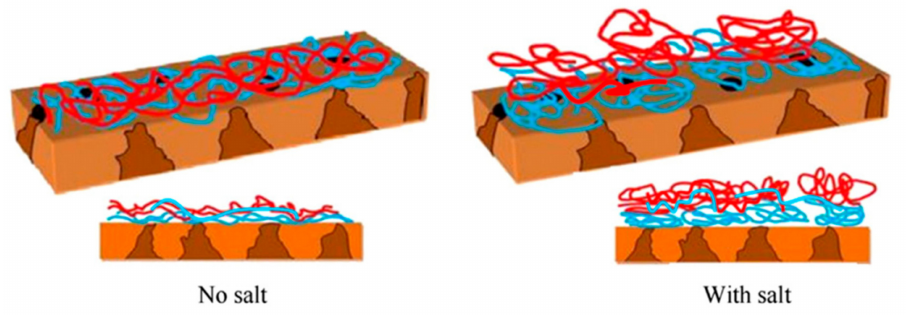
Figure 10. Effect of salt addition towards polyelectrolyte chains and thin film thickness (the NaCl concentration increases from 0 to 1.0 M). Reproduced with permission from Reference